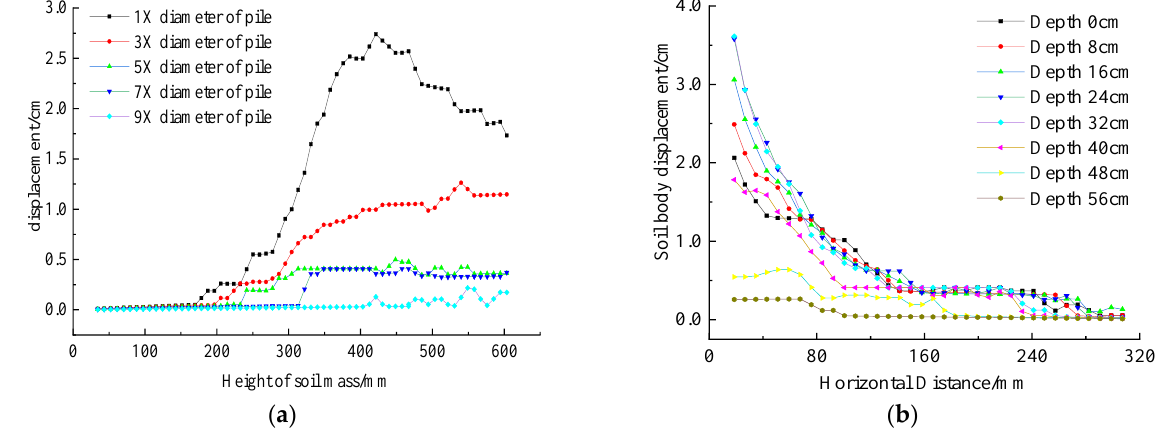
Figure 17. Influencing factors of soil displacement around piles and response law curve for the ( a ) curve of relationship between soil body displacement and the depth along pipe pile and ( b ) relationship curve between soil body displacement and distance from pipe pile.